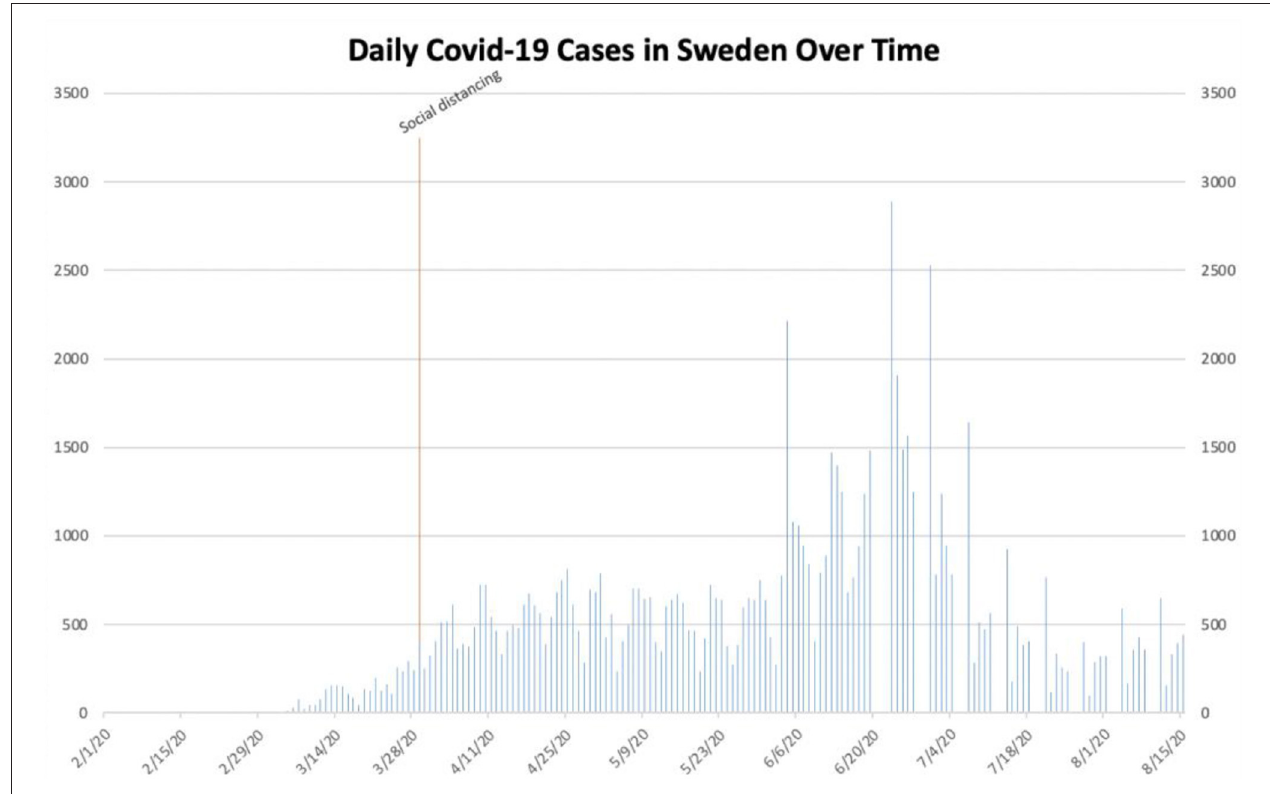
FIGURE 7 | Daily COVID-19 cases in